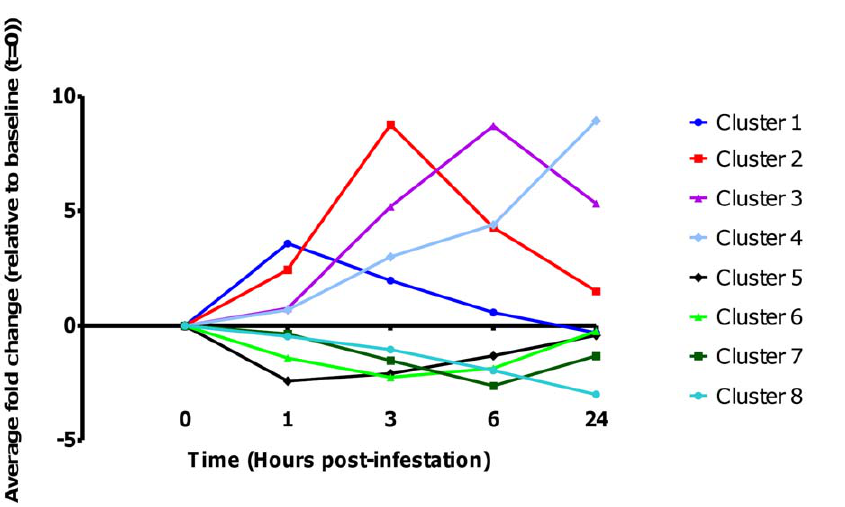
Figure 1. Clustered mean temporal gene expression profiles post-infestation with P.ovis . Chart shows the mean gene expression profiles for clusters 1–8. Time (hours) post infestation highlighted on X-axis (0, 1, 3, 6 and 24 hours) and mean fold change compared to time zero sample on the Y-axis.